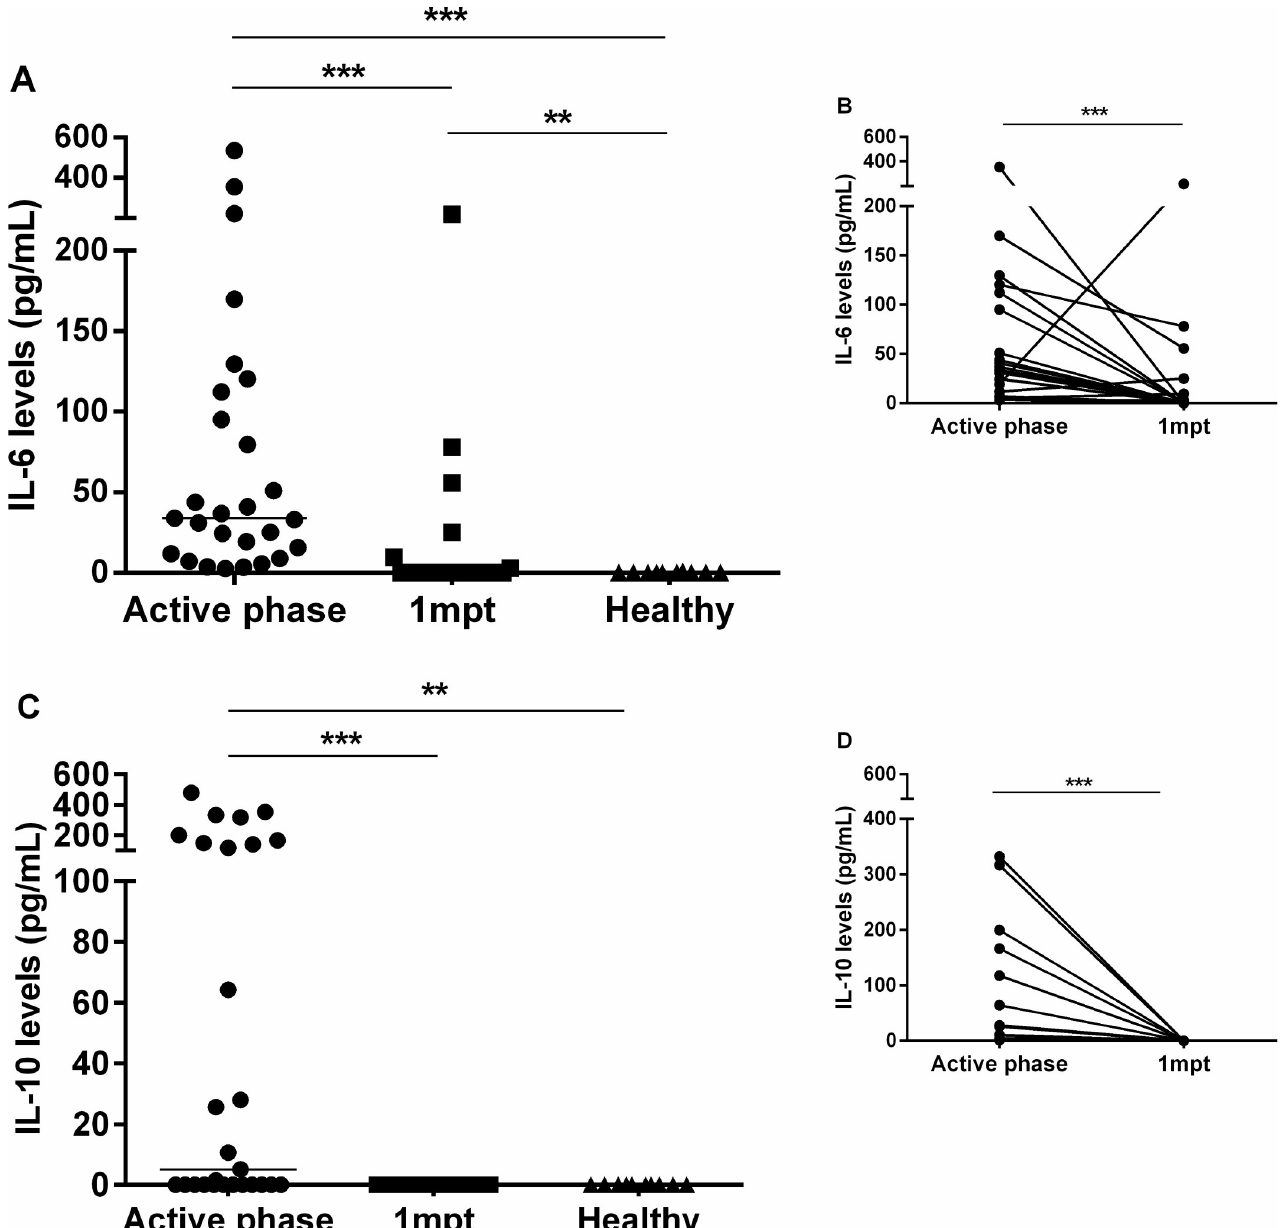
Fig 3. Plasma IL-6 and IL-10 levels in visceral leishmaniasis (VL) patients during clinical follow up. (A) IL-6 and (C) IL-10 levels were analyzed in the active phase and one-month post-treatment (1 mpt) in VL patients and in healthy volunteers. (B and D) The insert shows the IL-6 and IL-10 levels from the same patients prospectively evaluated in two different time points (n = 22). Each symbol represents one patient. The horizontal bar represents the median values. Asterisks denote a statistically significant difference between groups, � p < 0.05; �� p < 0.01.